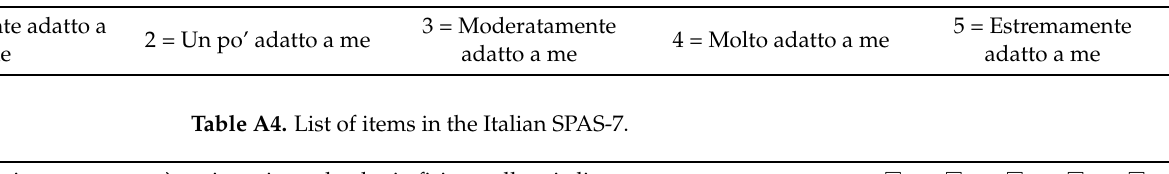
Table A3. Instructions: Di seguito sono presentate alcune affermazioni relative al Suo aspetto fisico. Con “fisico” e “linea” intendiamo la forma e la struttura del Suo corpo, ovvero il grasso corporeo, il tono muscolare e le proporzioni del corpo in generale. Legga ogni affermazione attentamente ed indichi quanto ciascuna si adatta a Lei.